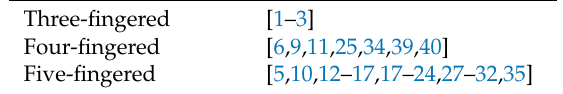
Table 3. Related work—Robotic hands kinematic structure